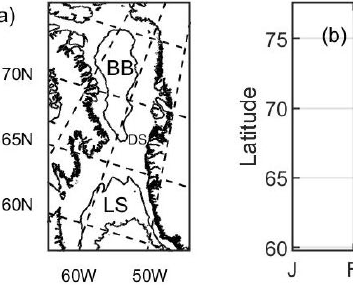
Figure 3. ( a ) Study area. BB: Baffin Bay; LS: Labrador Sea; DS: Davis Strait. ( b ) Hovmöller diagram (month vs. latitude) of CDOM spectral slope coefficient S 275–295 (nm − 1 ) averaged within 60 km from the west Greenland coast based on MODIS observations.